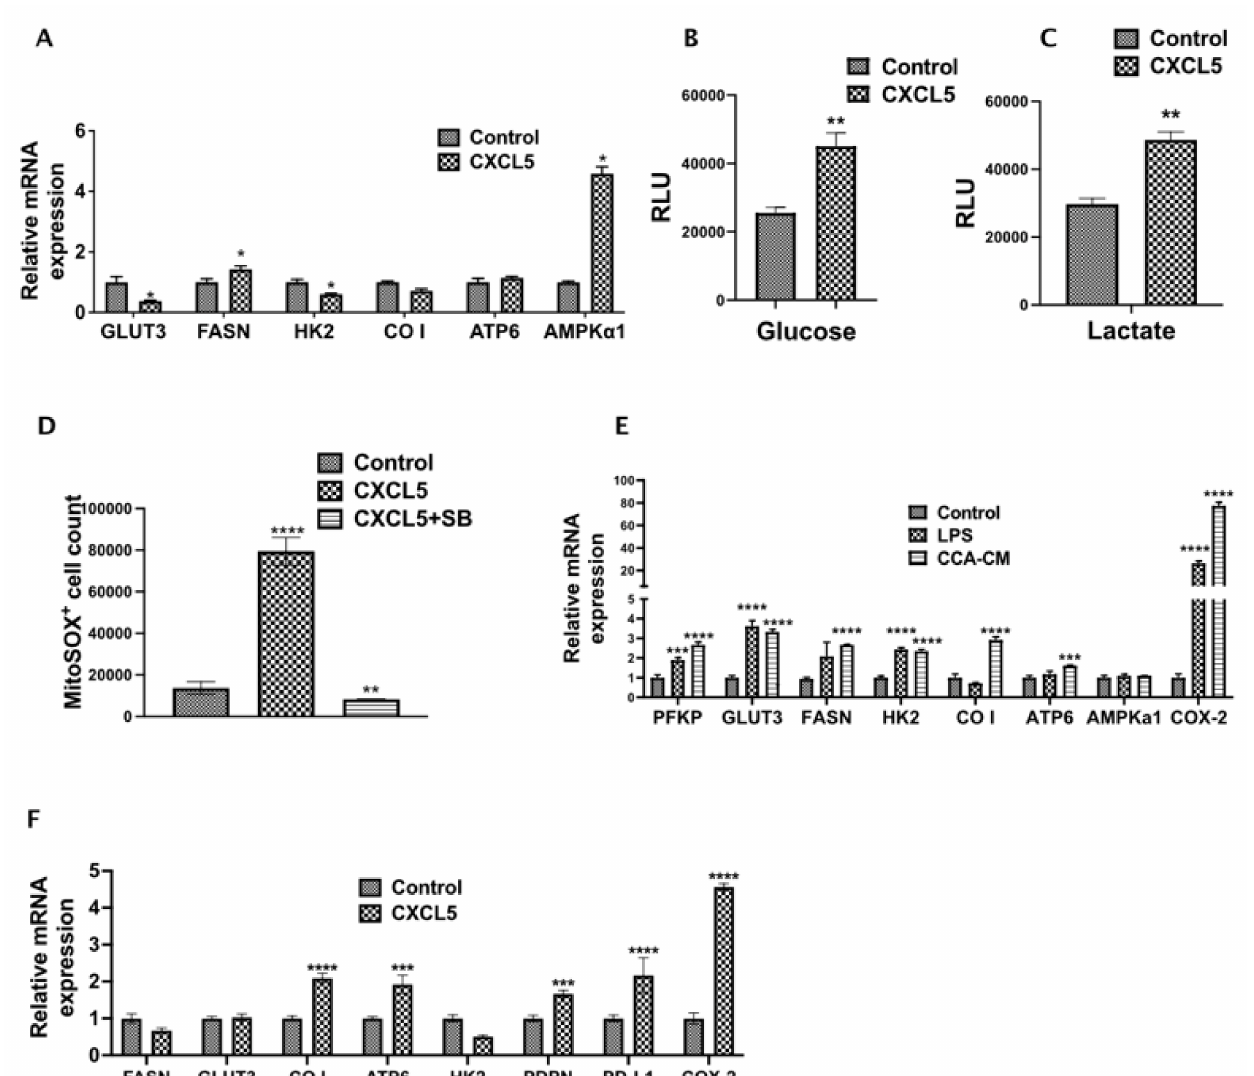
Figure 6. CXCL5 directly contributes to altered CCA metabolism and increases lactate production, glucose uptake and mitochondrial ROS. ( A ). CCA cells were treated with or without CXCL5 for 24 h and the expression of genes involved in glucose and fatty acid metabolism were assessed by qPCR. Values are represented as mean ± SEM, n ≥ 3. * p ≤ 0.05 represents value significantly different than control. ( B , C ) CCA cells were treated with or without CXCL5 for 24 h and the levels of ( B ) glucose and ( C ) lactate were analyzed using Glucose Glo assay and Lactate Glo assay respectively. All values are represented as mean ± SEM, ** p ≤ 0.01 represents value versus control. ( D ) CCA cells were pretreated with or without SB and then with or without CXCL5. Levels of reactive oxygen species produced was followed by staining the cells with MitoSOX followed by flow cytometry. ** p ≤ 0.01 and **** p ≤ 0.0001 represents value significantly different than control ( E ). CCA-LEC crosstalk and inflammation induce metabolic gene expression in LECs. mRNA levels of critical metabolic genes were measured by qPCR. Values represent mean ± SEM, n ≥ 3. Values are represented as mean ± SEM, n ≥ 3. *** p ≤ 0.001 and **** p ≤ 0.0001 represents value versus control. ( F ) LECs were treated with CXCL5 for 24 h and the expression of metabolic genes were followed by qPCR as above. All values are represented as mean ± SEM, n ≥ 3. *** p ≤ 0.001 and **** p ≤ 0.0001 represents value versus